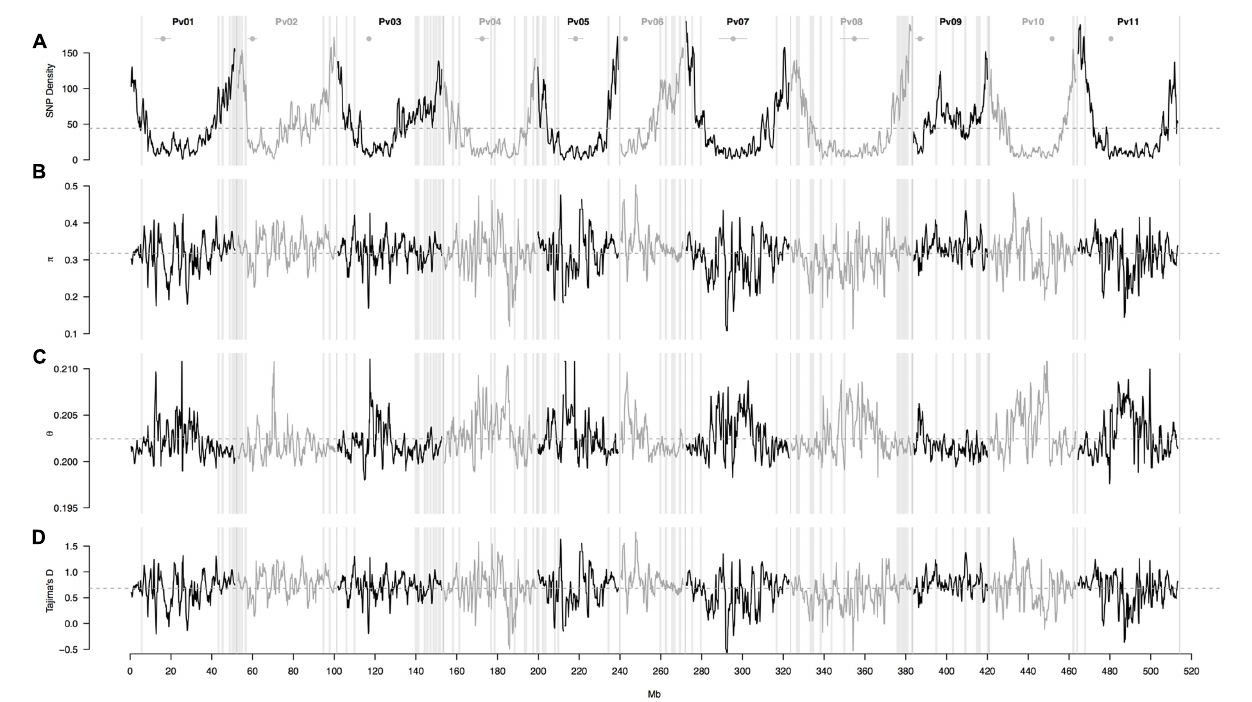
FIGURE 4 | Patterns of genome-wide diversity in 86 common bean accessions based on 22,845 GBS-derived SNP markers. A sliding window analysis (window size = 1 × 10 6 bp, step size = 200 kb) was used to compute (A) SNP density, (B) nucleotide diversity as measured by π , (C) Watterson’s theta estimator ( θ ), and (D) Tajima’s D. Results of all windowed analyses are plotted against window midpoints in millions of base pairs (Mb). Black and gray colors highlight different common bean (Pv) chromosomes. Gray dashed horizontal lines indicate genome-wide averages. Gray vertical boxes indicate the 1,000 bp flanking region of each marker that was associated with the bioclimatic-based drought index (Figure 3) . Horizontal gray lines with a central filled gray dot at the top of the figure mark the centromeres according to Schmutz et al. (2014).